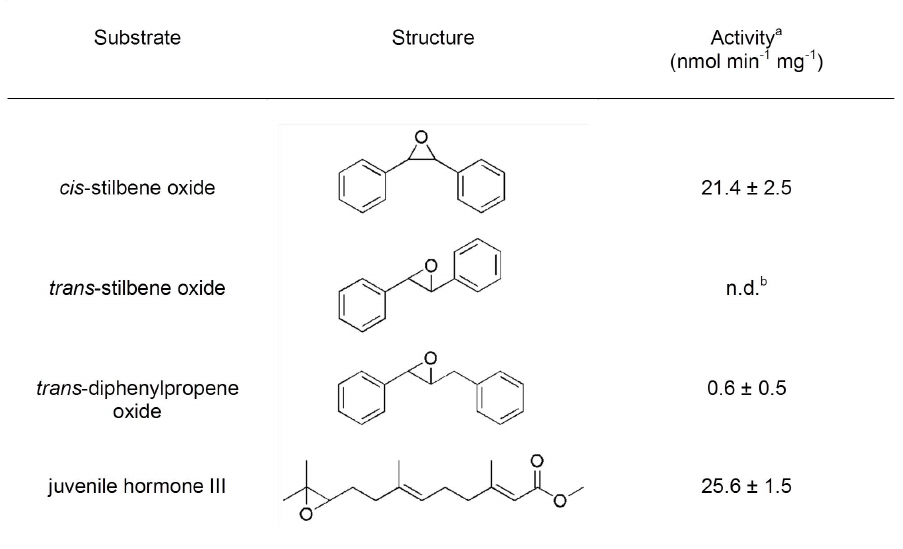
Figure 9. Activity of recombinant Hovi-mEH1 with various epoxide-containing substrates. The enzyme assays were performed at 30 u C in buffer (100 mM sodium phosphate, pH 8.0) containing 50 m M epoxide-containing substrates, 1% (v:v) ethanol, and 0.1 mg ml 2 1 BSA. The juvenile hormone III assays also contained 10 m M 3-Octylthio-1,1,1-trifluoropropan-2-one (OTFP) and additional ethanol (2% v:v). The values shown are the mean 6 standard deviation of at least three separate experiments. Similar values were obtained for these substrates with Hovi-mEH1 from another baculovirus expression construct. Activity was not detected at an assay detection limit of 0.1 nmol min 2 1 mg 2 1 .